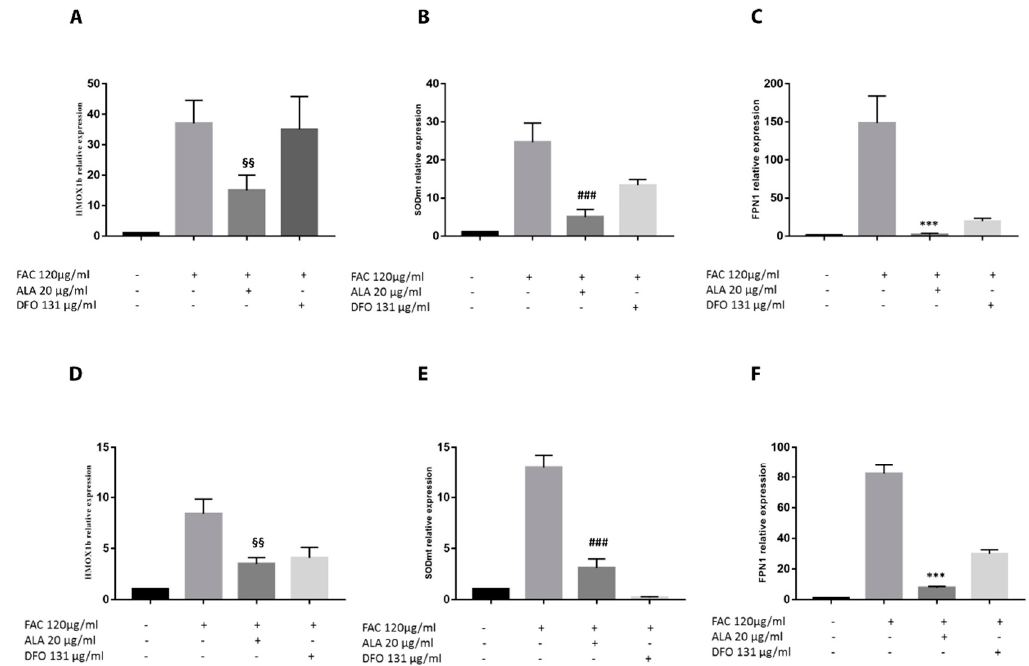
Figure 6. Effect of ALA on oxidative stress parameters of zebrafish liver and intestine. Gene expression analysis was performed following FAC treatment (120 µ g/mL) alone and in combination with ALA (20 µ g/mL) and DFO (131 µ g/mL) for 48 h in zebrafish liver and intestine. HMOX1b, mtSOD (oxidative stress markers), and FPN1 levels were measured in the liver ( A – C ) and intestine ( D – F ) (HMOX1b: §§ p < 0.001; mtSOD: ## p < 0.001; FPN1: *** p < 0.0001 vs. FAC treatment). Calculated value of 2 ∆∆ C t in untreated controls was 1. Data are expressed as mean ± SD of at least three independent experiments.